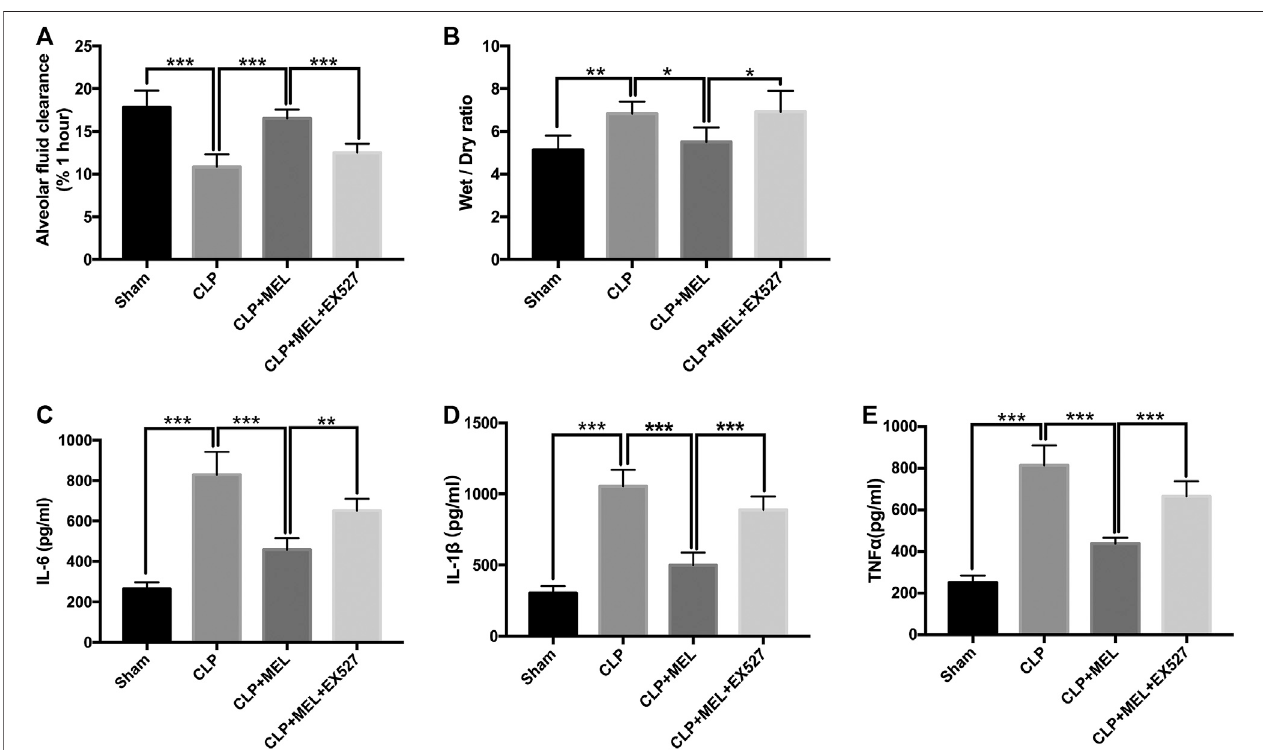
FIGURE 3 | Melatonin increased AFC and alleviated in fl ammatory mediators in BALF. (A) The AFC in ALI mice was determined (B) Lung wet/dry weight ratio was tested. The levels of IL-6 (C) , TNF- α (D) and IL-1 β (E) in BALF were tested by ELISA kit. All values are means ± SD ( n (cid:1) 6). *** p < 0.001; ** p < 0.01; * p < 0.05 (one-way ANOVA followed by Turkey post hoc